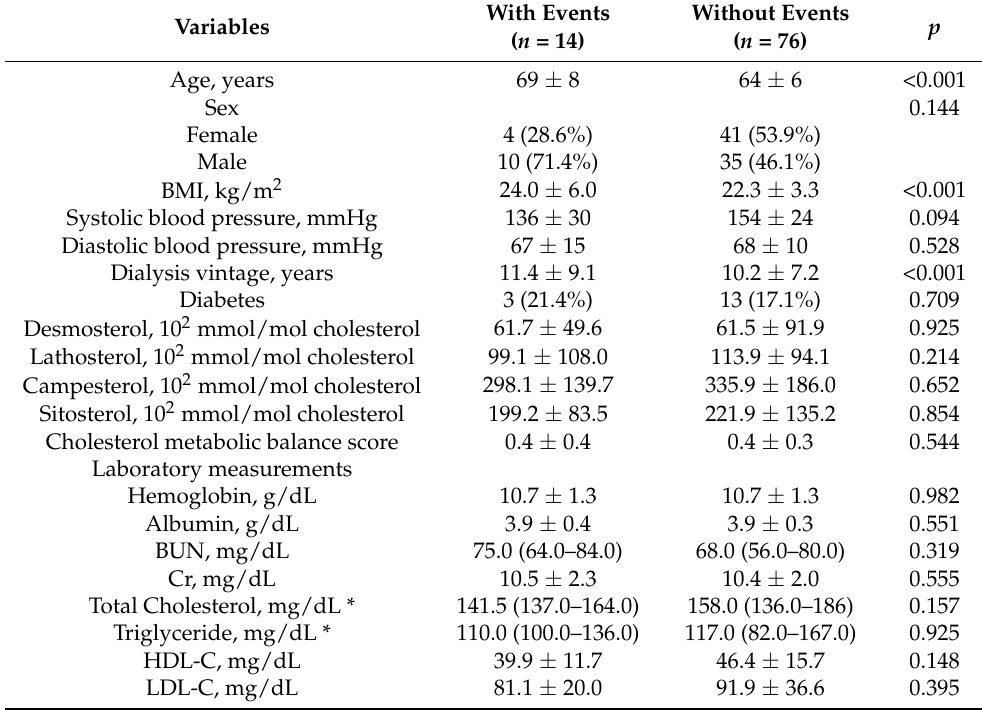
Table 2. Baseline characteristics in HD patients with and without macrovascular events ( n =